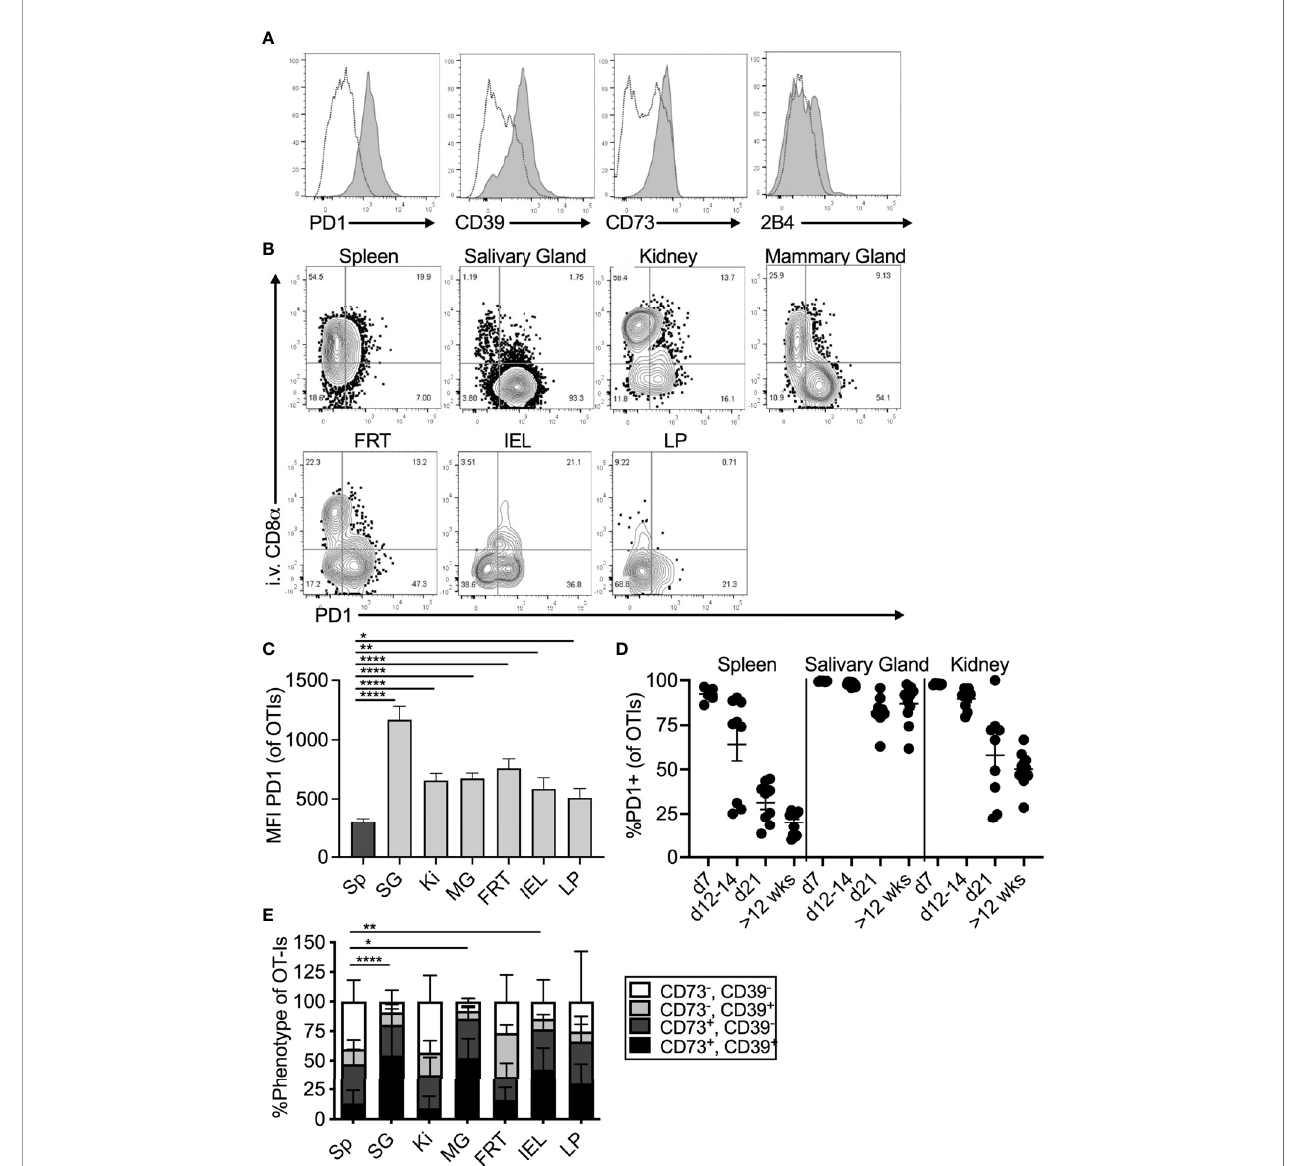
FIGURE 1 | Expression of inhibitory molecules on MCMV speci fi c T cells in the salivary gland. Mice were seeded with OT-Is and infected with MCMV-OVA. At least 3 months post infection mice were injected i.v. with fl uorochrome labeled anti-CD8 a antibody and sacri fi ced 3 minutes later. (A) Representative FACS plots show inhibitory molecule expression on i.v. antibody-negative salivary gland OT-Is (grey histograms) compared to total (i.v. negative and i.v. positive combined) spleen derived OT-Is from the same animal (open histograms, n=5 from 3 independent experiments). (B) Representative FACS plots of OT-Is isolated from the indicated organs showing PD-1 expression relative to staining by the intravenously injected CD8 a antibody. (C) Mean fl uorescence intensity of PD-1 staining on OT-Is from the indicated organs, (n=6-9 mice from 3 experiments). Data show the mean of all mice and error bars show the standard error of the mean. (D) Frequency of PD-1 expression on OT-Is from the spleen, salivary gland and kidney over time (n=6-11 from 2-4 independent experiments at each time point). Horizontal lines represent the mean and error bars show the standard error of the mean. (E) Frequency of CD73 and CD39 expression on OT-Is isolated from the indicated organs, (n=4-13 from 4 independent experiments). Data show the mean of all mice and error bars show the standard error of the mean. Statistical signi fi cance in all cases, was tested by direct comparisons between pairs of organs using paired, two-tailed student ’ s t-tests. For simplicity and clarity, shown are signi fi cant differences between spleen and other organs. *p ≤ 0.05, **p ≤ 0.01, ***p ≤ 0.001, ****p ≤